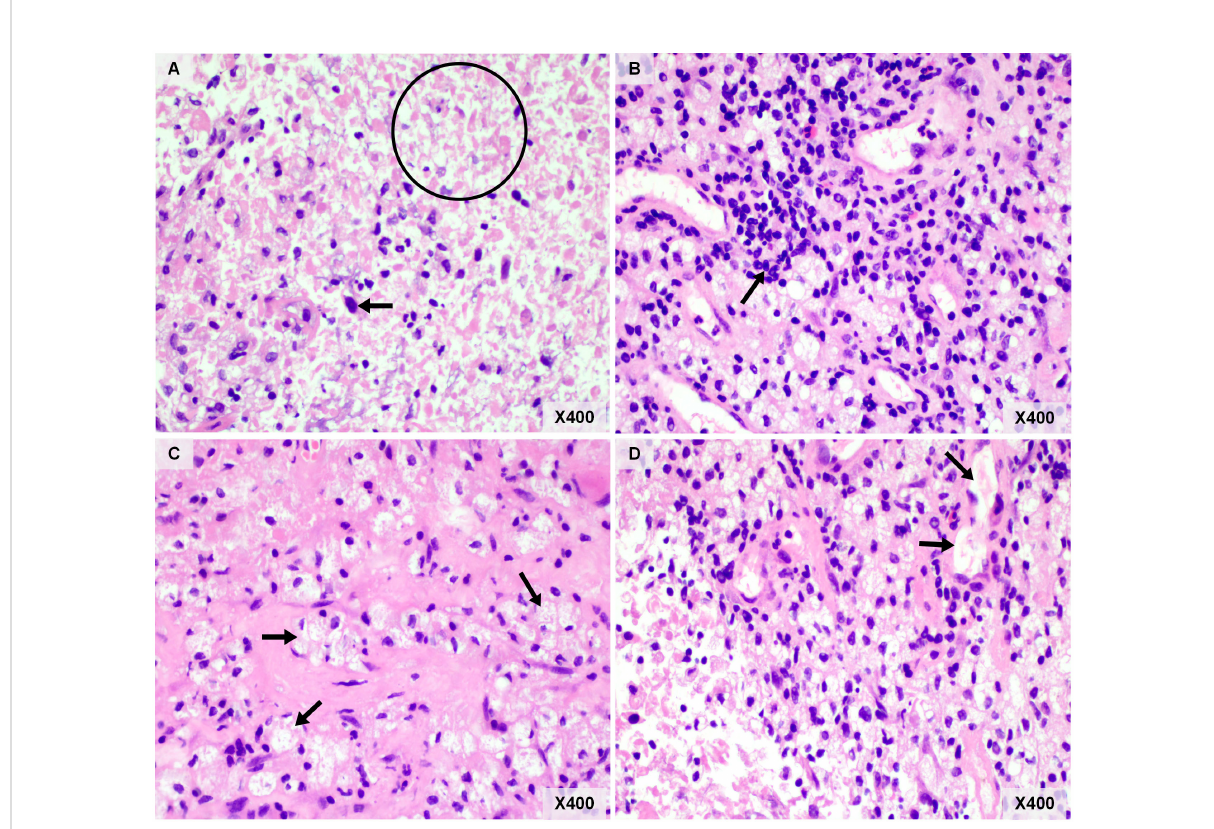
FIGURE 3 Pathological examination of resected brain metastasis. (A) Necrosis was common in brain metastasis (circle), and necrotic tumor cells (arrow) can be observed. (B) Lymphocytic in fi ltration (arrow). (C) There are numerous foam cells (arrows) were seen in the visual fi eld. (D) The neovascularization was seen around the tumor bed (arrows). Original magni fi cation: Panel (A – D) , hematoxylin and eosin,